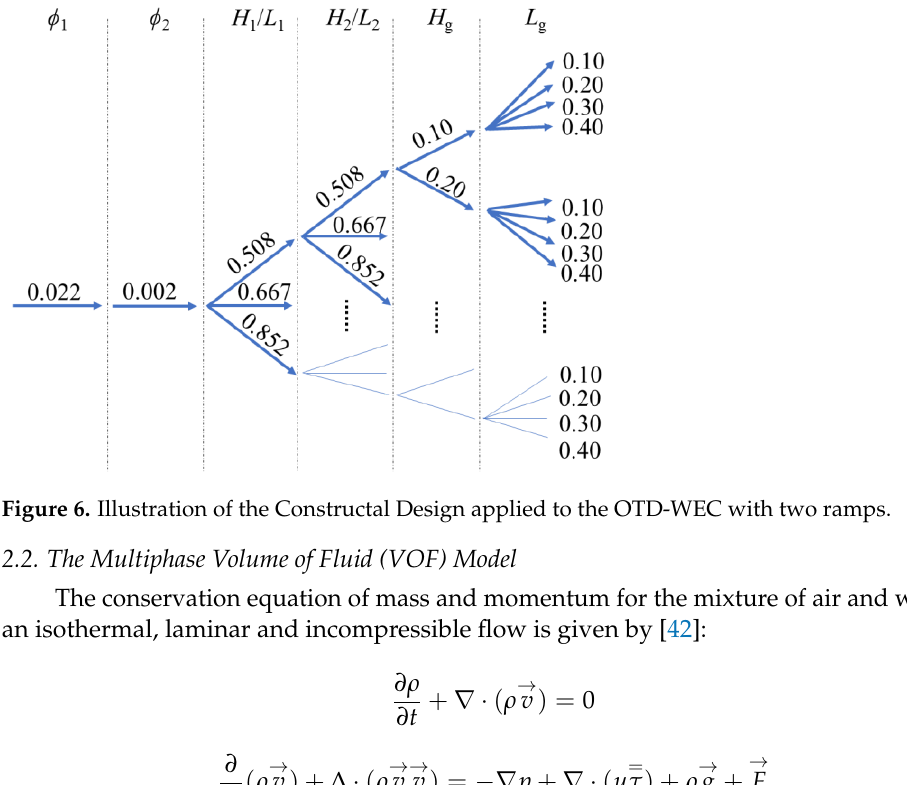
Figure 5. Illustration of the Constructal Design applied to the OTD-WEC with one ramp.